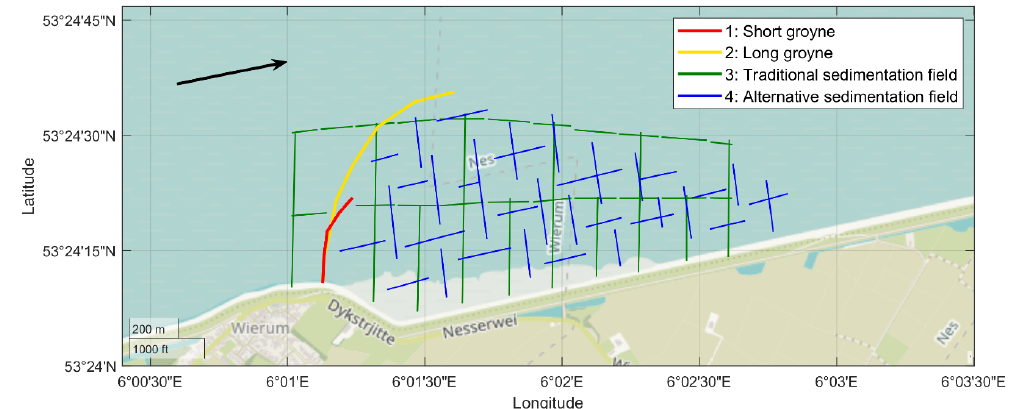
Figure 5. Visualization of the locations and shapes of the structures implemented within the model. The arrow indicates the dominant direction of tidal flow and alongshore